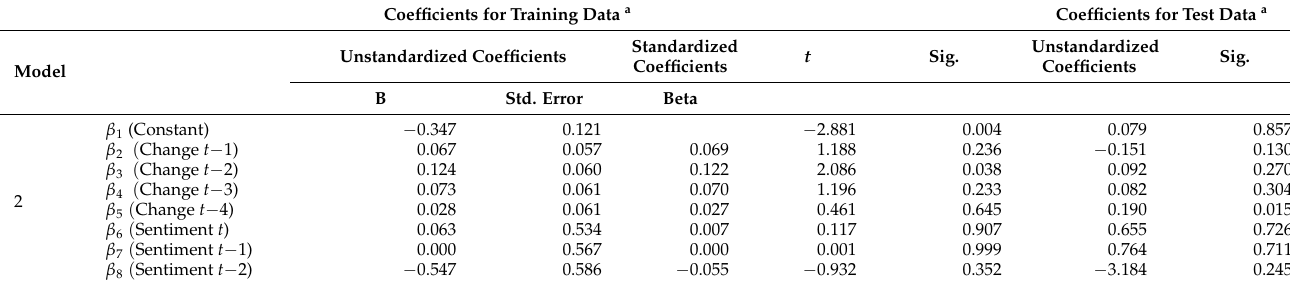
Table 3. Linear autoregression with exogenous factor coefficients.